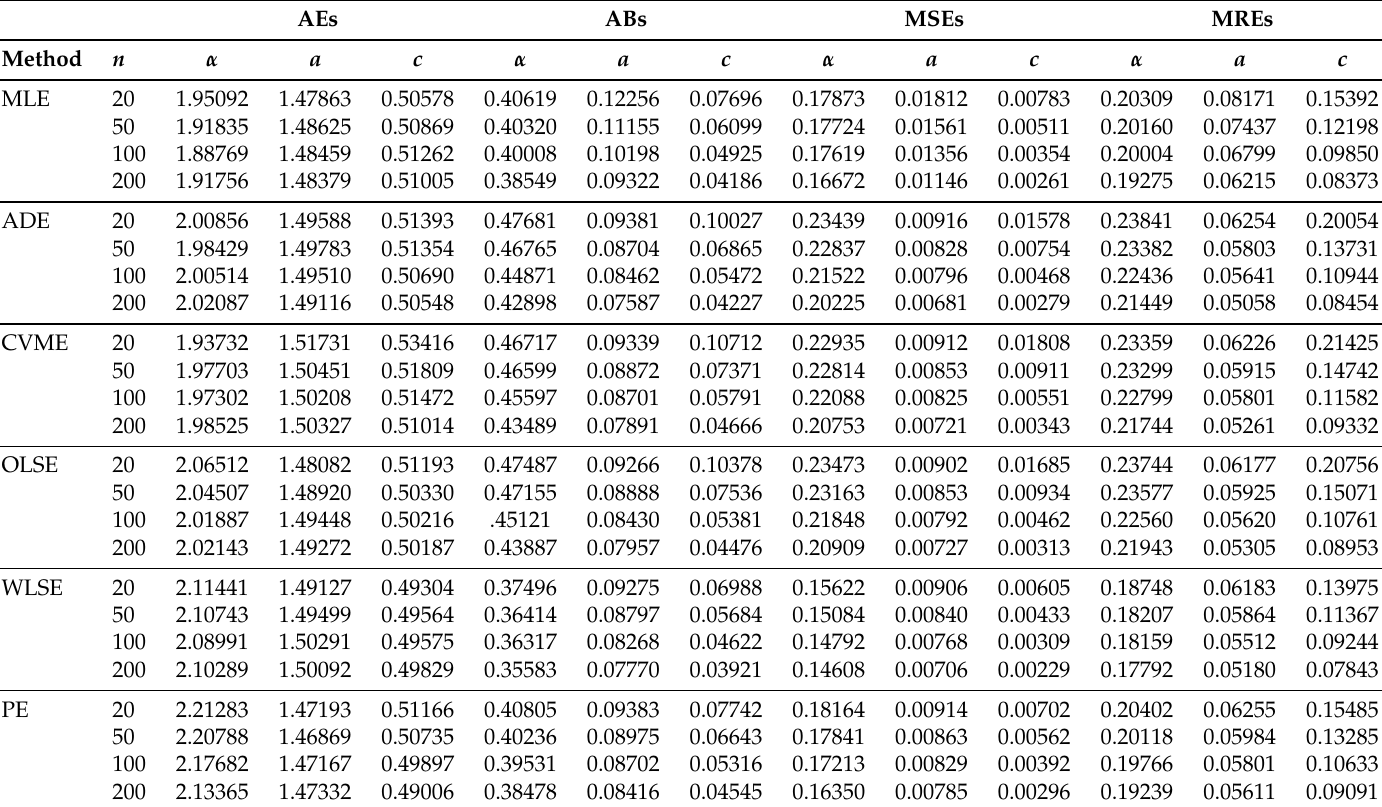
Table A3. The AEs, ABs, MSEs, and MREs for ( α = 2, a = 1.5, c = 0.5 )